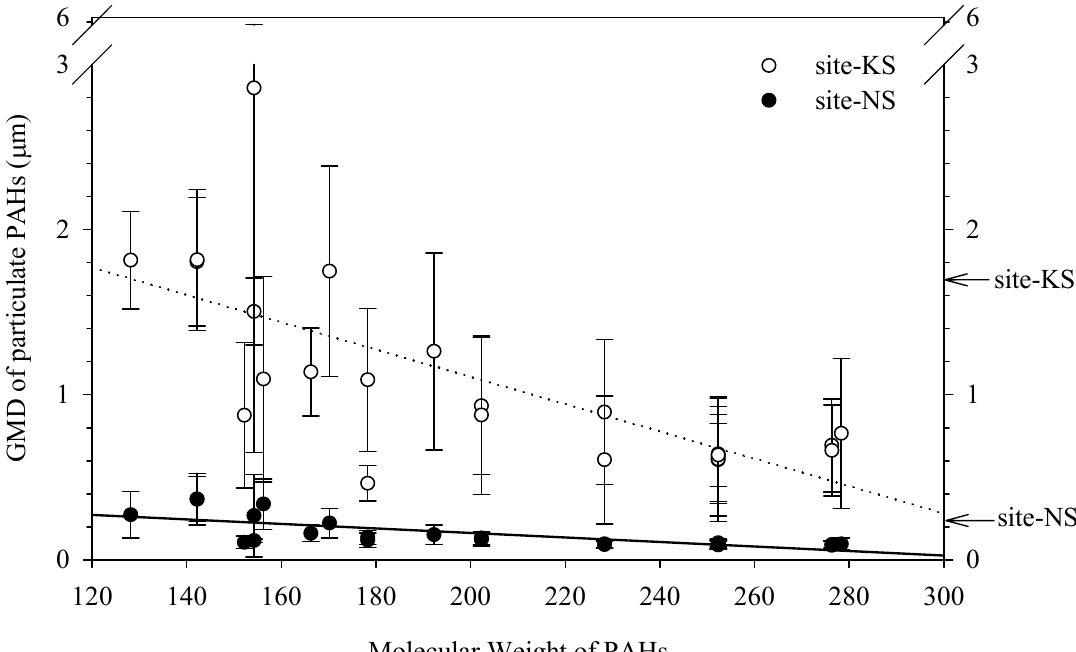
Figure 3. Variation of geometric mean diameter (GMD) of particulate PAHs in air. (log GMD = Σ m log Dp / Σ m , where m and Dp are the mass of individual PAHs and the i i i i i geometric mean particle diameter, respectively, of size class i). Circles and error bars denote annual mean and one standard deviation of GMDs, respectively. Arrows at right axis represent the annual GMDs of PM at KS (1.7 ±1.0 μ m) and at NS (0.23 ± 0.15 μ